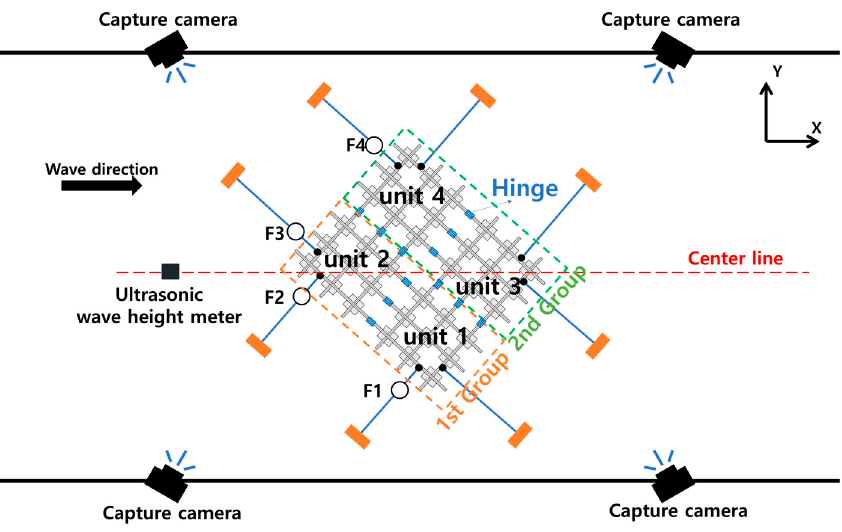
Figure 5. Diagram of the experimental setup for oblique sea conditions.